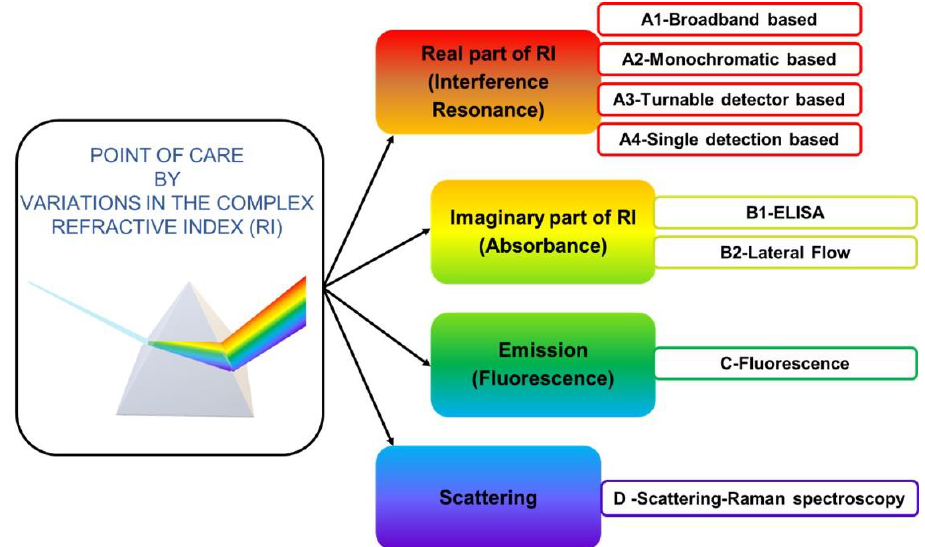
Figure 7. A schematic representation of the classification of PoC by optical detection method classified into four categories: Real part of RI (interference – resonance), Imaginary part of RI (absorbance), emission – fluorescence, and scattering.